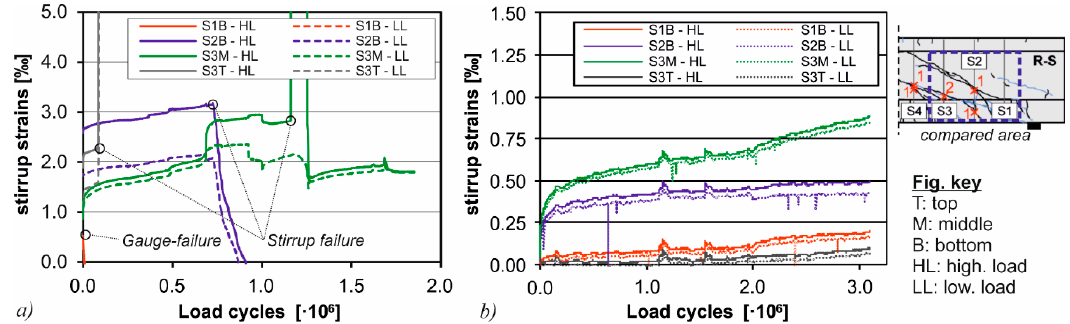
Figure 12. Stirrup strains in the vicinity of the supports for ( a ) M-22-7; and ( b ) CTRM-M-22-7.